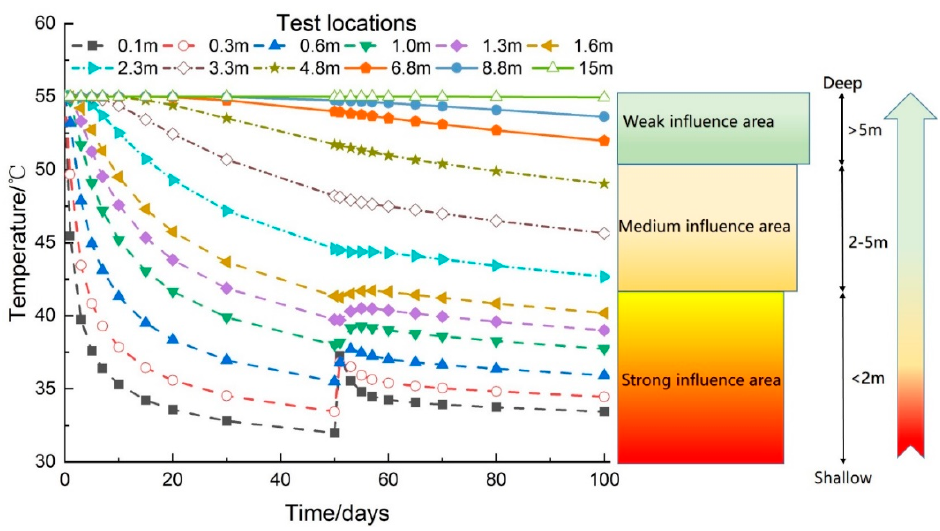
Figure 12. Influence of excavation and cooling measurement on the surrounding rock temperature.